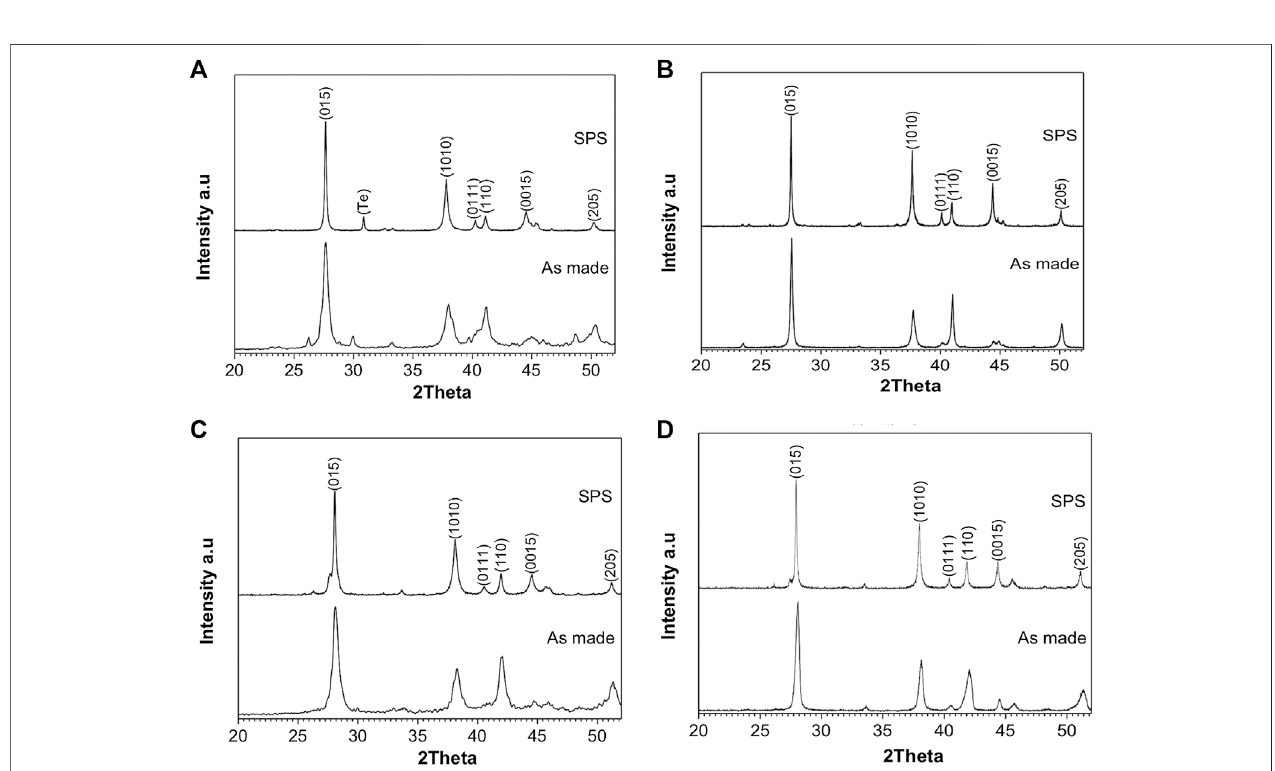
FIGURE1| X-raypowder diffraction patterns ofas-synthesized and sparkplasmasintering(SPS) sintered samplesfor (A) mechanochemical alloying (MA)-Bi 2 Te 3 , (B) microwave-assisted (MW)-Bi 2 Te 3 , (C) MA-Bi 0.5 Sb 1.5 Te 3 , and (D) MW-Bi 0.5 Sb 1.5 Te 3 . The crystalline phases are indexed to Bi 2 Te 3 (ICDD: 00-015-0863) and Bi 0.5 Sb 1.5 Te 3 (ICDD: 00-049-1713) with rhombohedral crystal structure.